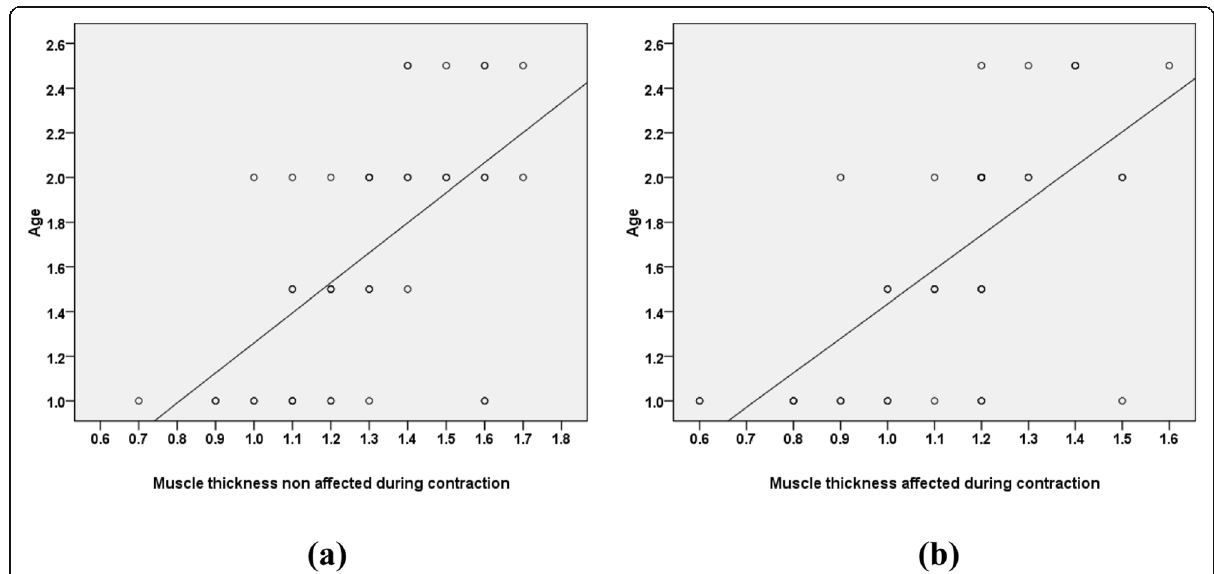
Fig. 4 a Correlation between age and muscle thickness in the nonaffected side during contraction ( r = 0.596; P = 0.001). b Correlation between age and muscle thickness in the affected side during contraction ( r = 0.658; P =